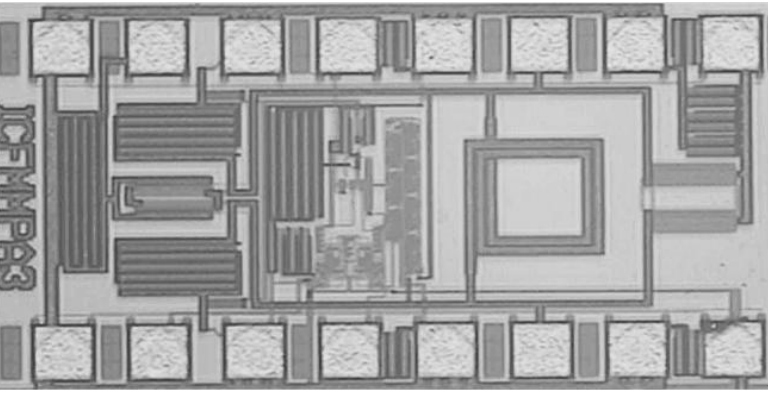
Figure 16. Photomicrograph of the fabricated PLL